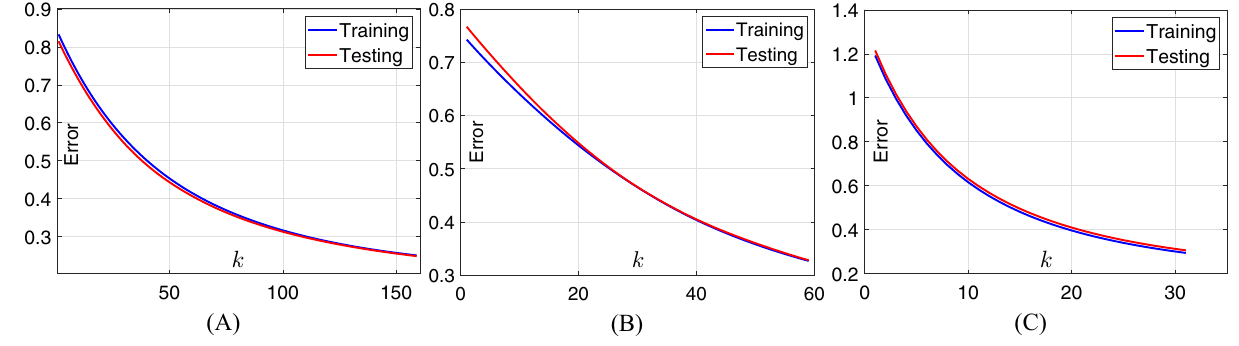
Figure 7. Trends of errors for training and testing dynamic learning network (DLN) in case 1 as the training round k increases. ( A ) DLN trained by NDLA with linear type of mapping function. ( B ) DLN trained by NDLA with tanh type of mapping function. ( C ) DLN trained by NDLA with sinh type of mapping function.